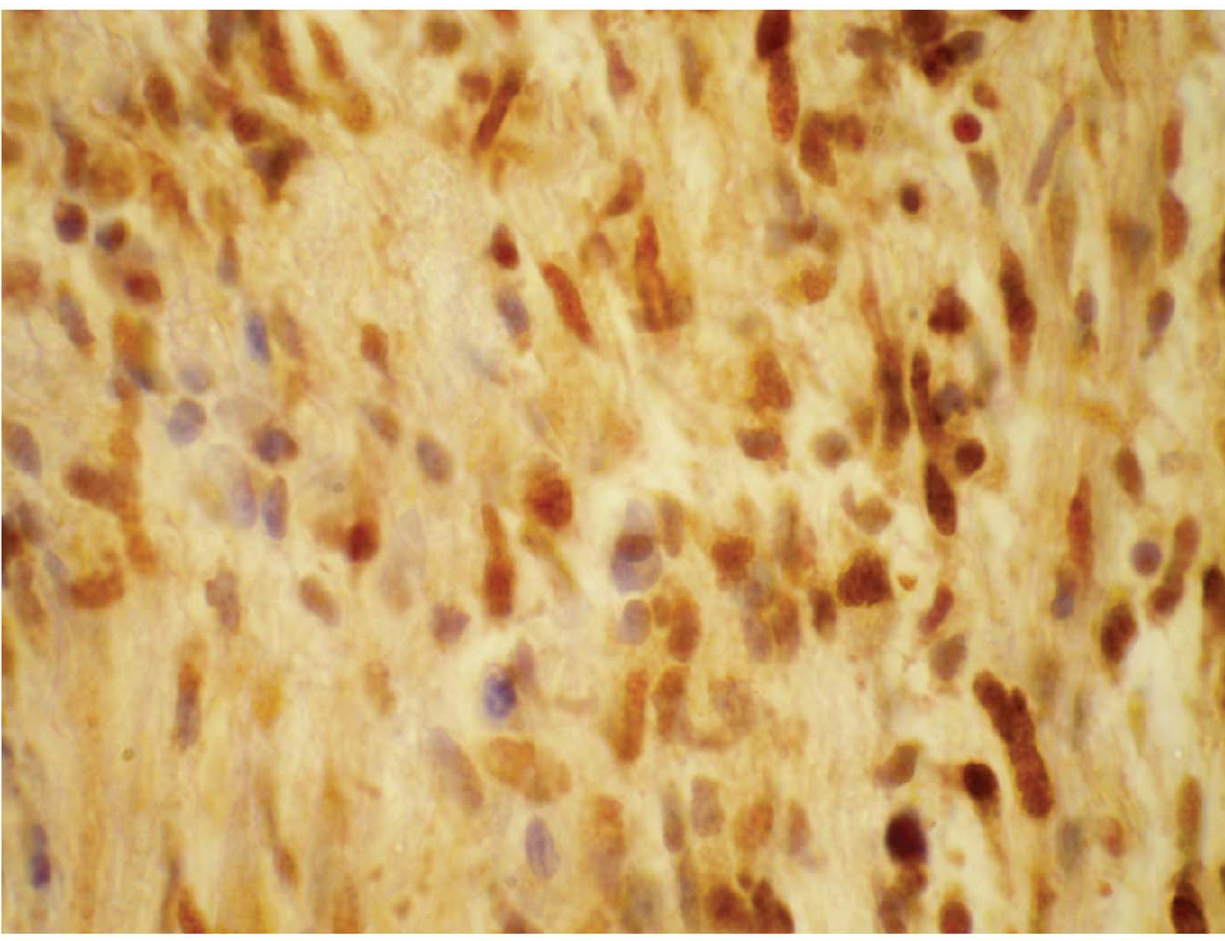
Figure 8. Nerve stained for TGF- b . Nerve showing TGF- b positive macrophages. IHC staining 6 100.